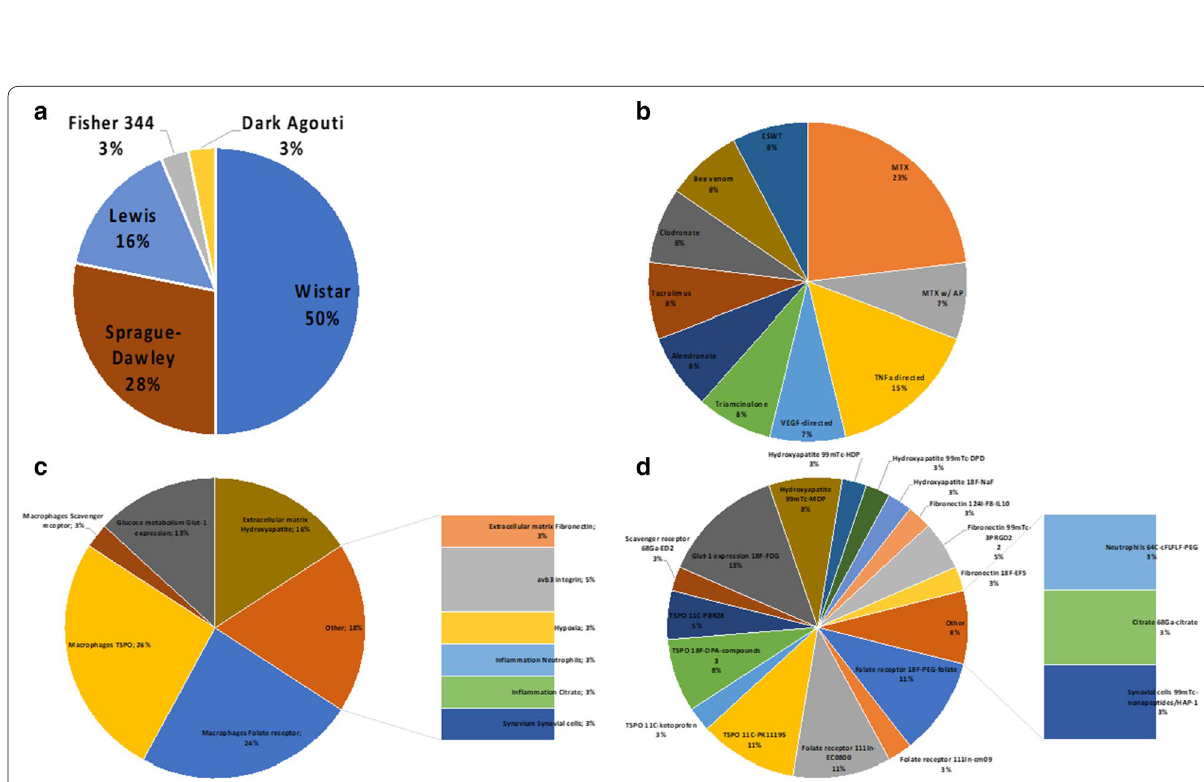
Fig. 2 Overview of rat models used ( a ), the type of interventions reported ( b ) and the imaging tracers and targets described in these studies ( c , d